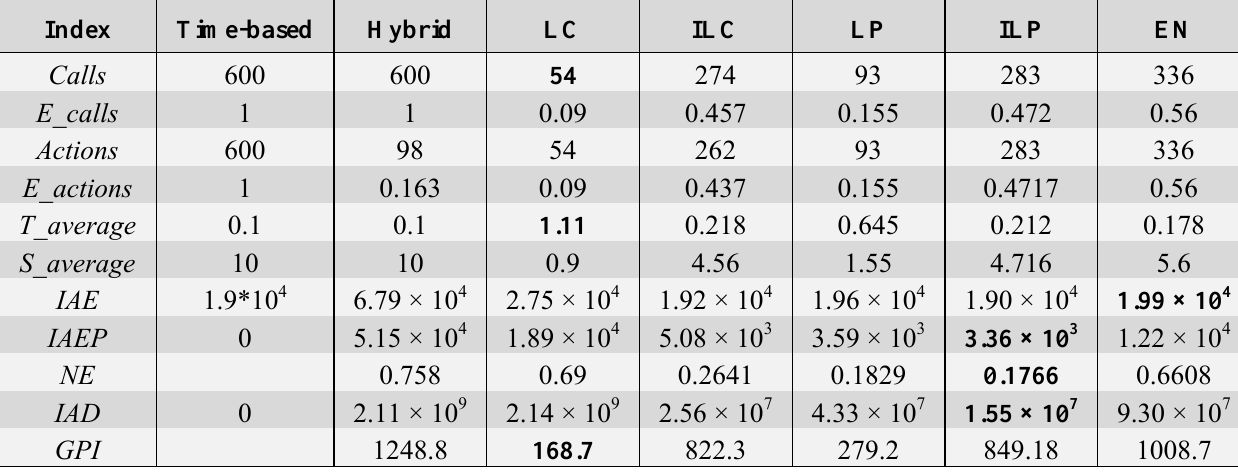
Table 7. Performance of the hybrid and event-based approaches for  disturbance. Figures in bold represent the best value of every performance index in the hybrid and event-based